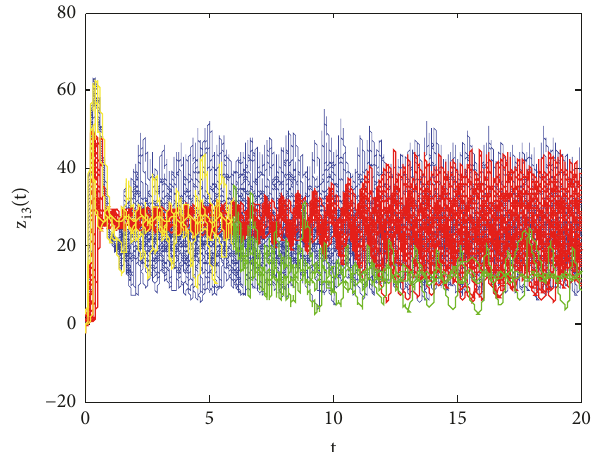
Figure 10: (Color online) Less node control community network 𝑧 (𝑡) with 𝑡 𝑖3